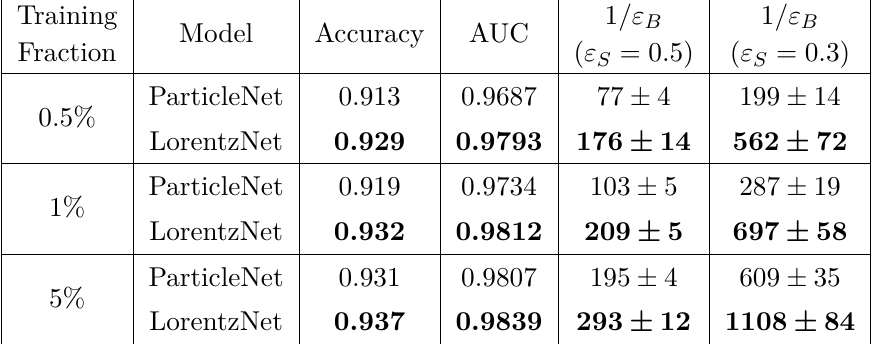
Table 3 . Performance comparison between LorentzNet and ParticleNet on top tagging dataset by a fraction of training data. The results are all averaged on 6 runs.